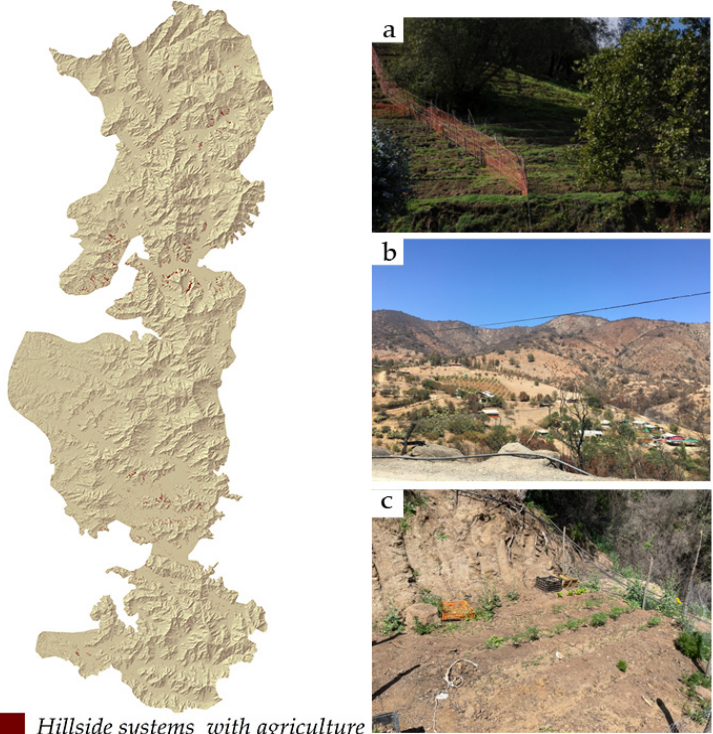
Figure 9. Area of hillside systems with agriculture. Photographs ( a , b ) show examples of small-scale agriculture in the studied area, and ( c ) shows an example of agricultural restoration on degraded hillside systems.